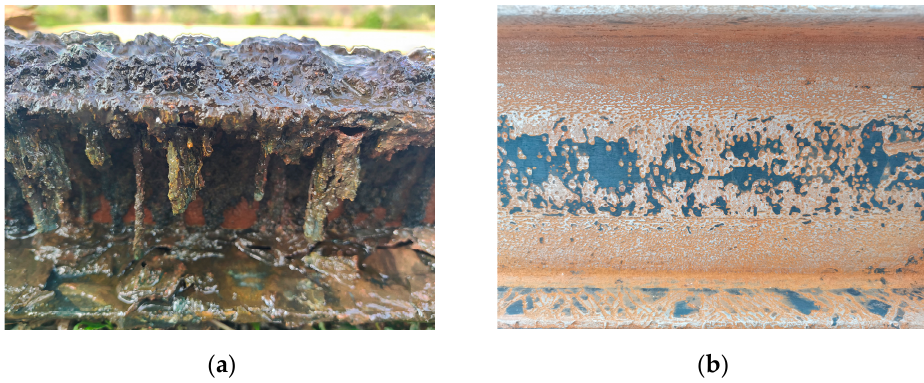
Figure 3. Specimens after corrosion: ( a ) Corrosion products; ( b ) Surface morphology of the speci- mens.